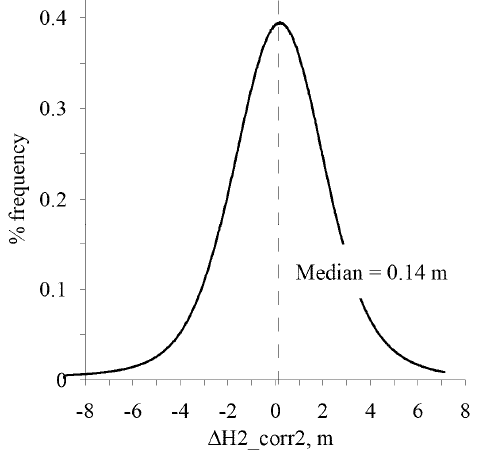
Figure 5. Frequency distribution of height differences ( Δ H2_corr2) within its 1–99 percentile range.